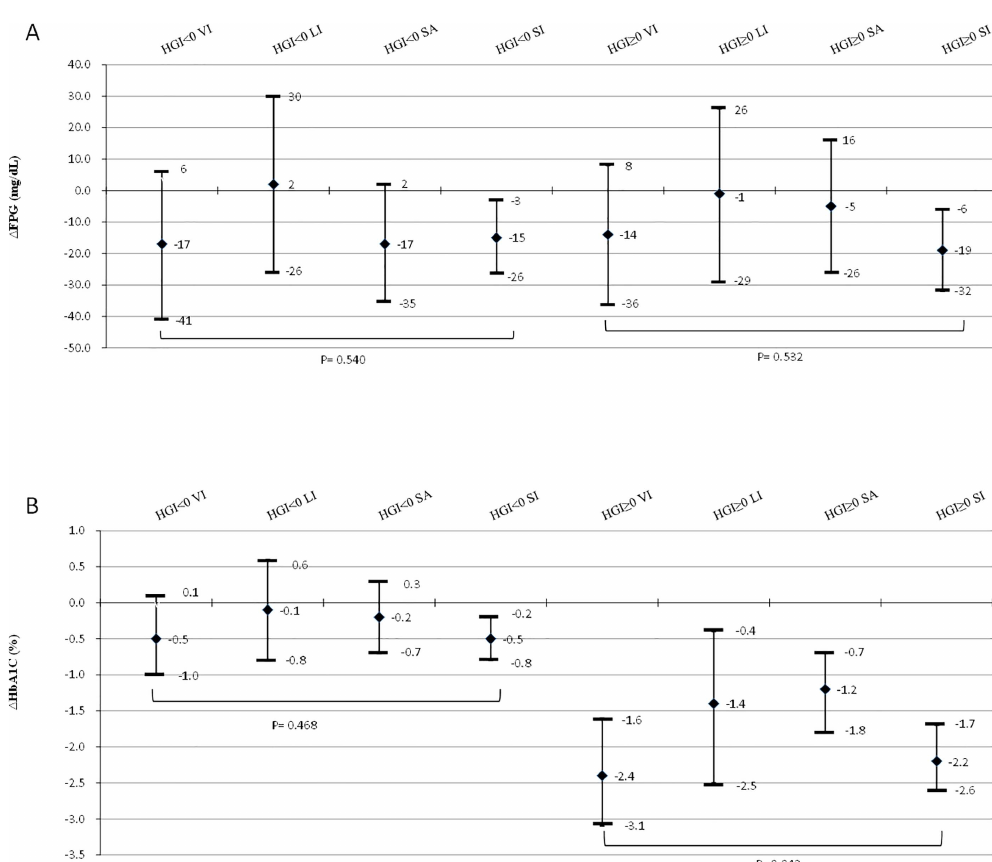
Fig 2. Comparisons of the effect of different dipeptidyl peptidase-4 inhibitor treatment for 1 year on adjusted mean changes in fasting plasma glucose (FPG) (A) and glycated hemoglobin (HbA 1 c) (B) in the patients with a low and high hemoglobin glycation index (HGI). Factors includedin the analysisof variance statistical model were baselineoral anti-diabetes drugs, age, sex and renal function. VI = vildagliptin(n = 24 in the low HGI and n = 36 in the high HGI groups), LI = linagliptin(n = 33 in the low HGI and n = 31 in the high HGI groups), SA = saxagliptin(n = 45 in low HGI and n = 64 in the high HGI groups), SI = sitagliptin(n = 97 in the low HGI and n = 138 in the high HGI group). Error bars represent 95% confidenceinterval (CI). p-value for between-group difference. (To convert glucoseto millimolesper liter, multiply by